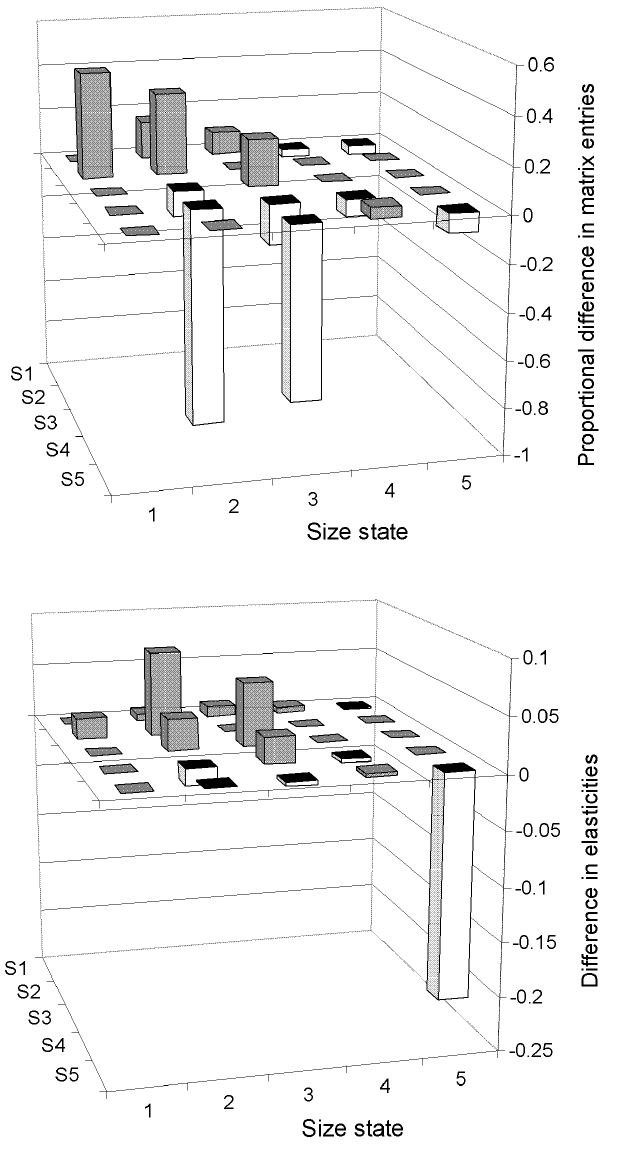
Figure 3. Proportional difference in matrix entries (above) and difference in elasticities (below) between the Isolated tributary and the Open system (values collapsed over locations for the Open system). Positive values (closed bars) represent higher matrix entries or elasticities for the Isolated tributary. doi:10.1371/journal.pone.0001139.g003 (Figure 4). This effect was most extreme for blocking access to OS only, where extinction was predicted within 2.9 years (90% confidence) or 3.2 years (95% confidence). In simulations where access to either OL or to both OL and OS was blocked, extinction was predicted within 10.1 years (90% confidence) or 11.2 years (95% confidence)(Figure 4).